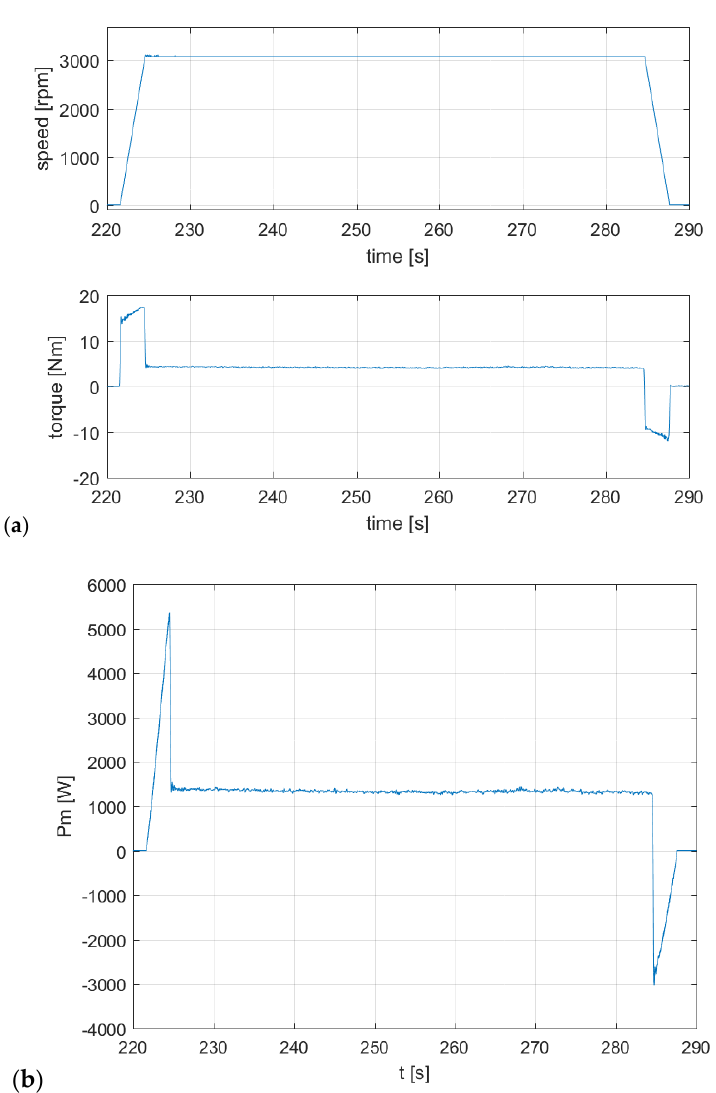
Figure 21. Recorded waveforms of torque, speed ( a ) and mechanical power ( b ) on the motor shaft during a given cycle of work A. Table 5. Measurement results for C and A cycle of the trolley travel drive.